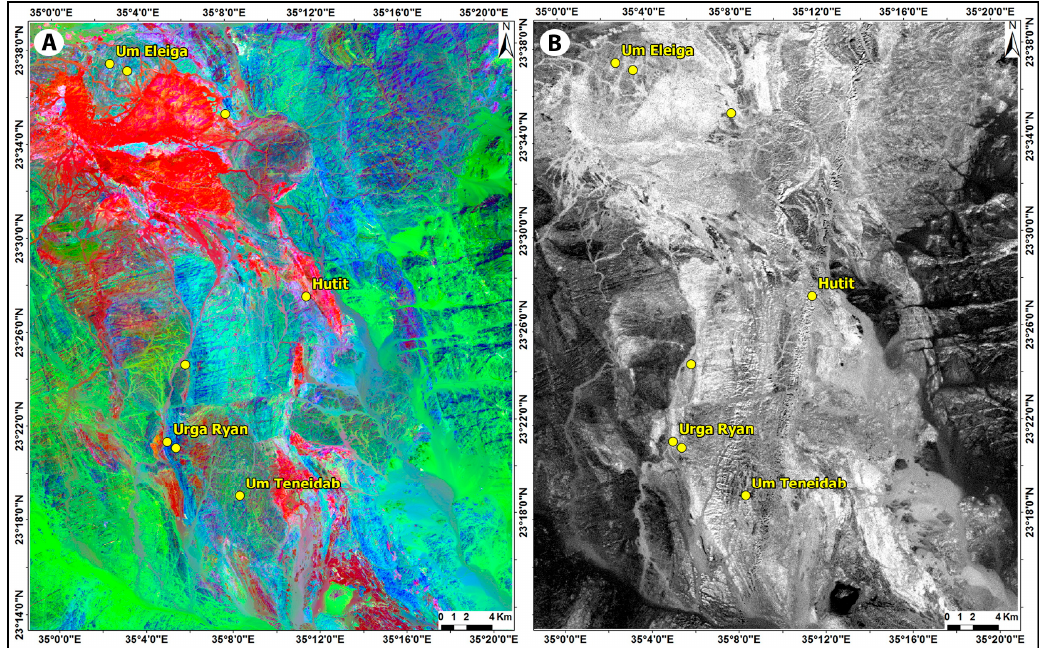
Figure 5. Ophiolitic mélange mapping promoted by processing OLI and ASTER data. ( A ) The FCC OLI-band ratio (R: 6/7, G: 6/2, B: 6/5×4/5) image discriminates terranes of the mafic rocks in the study area; ( B ) the grayscale ASTER RBD (6+9/8 2 ) image clearly highlight the ophiolitic mélange terrane in the central part of the study area and is surrounded by felsic rocks (granites and granitic gneisses) in the eastern and western parts of the